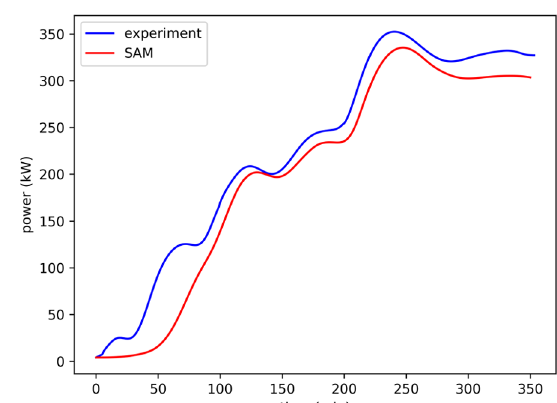
Figure 9. SAM result vs experimental measurement for the thermal-convection heat removal